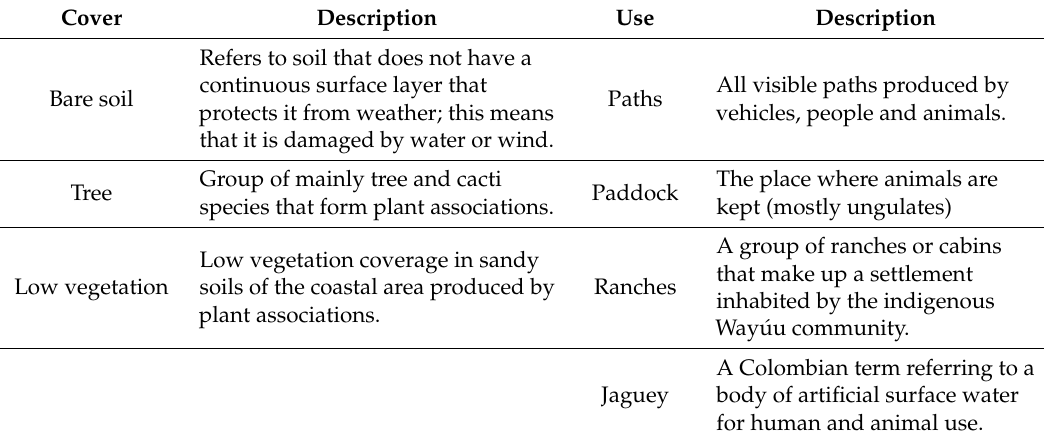
Table 5. Classes used to classify vegetation cover and land